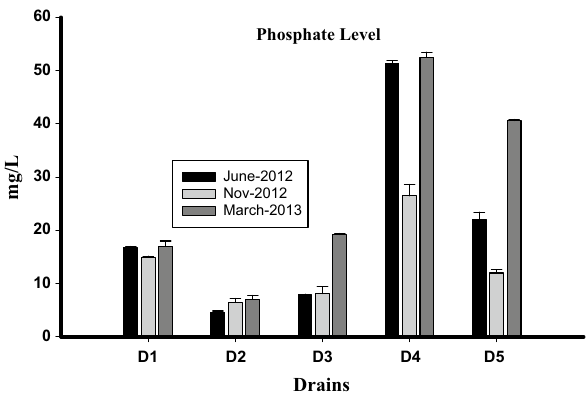
Fig. 2 BOD level of different drains of HIE. Red line shows the NEQS value